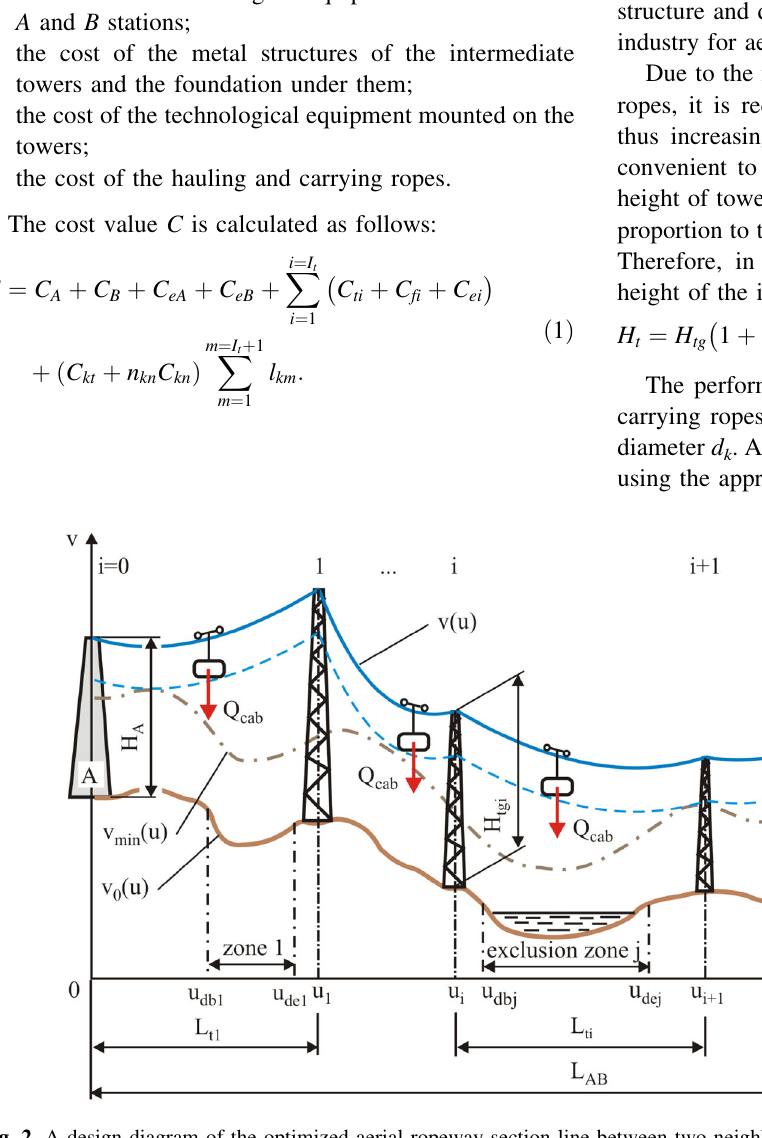
Fig. 2 A design diagram of the optimized aerial ropeway section line between two neighboring boarding stations ( A and B